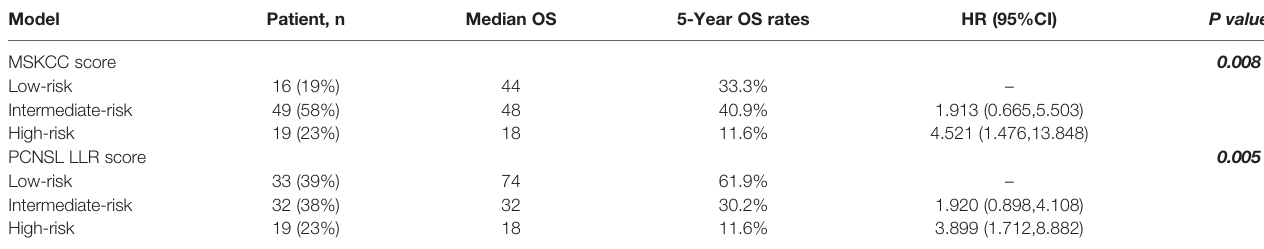
TABLE 7 | Validation of the novel PCNSL LLR scoring